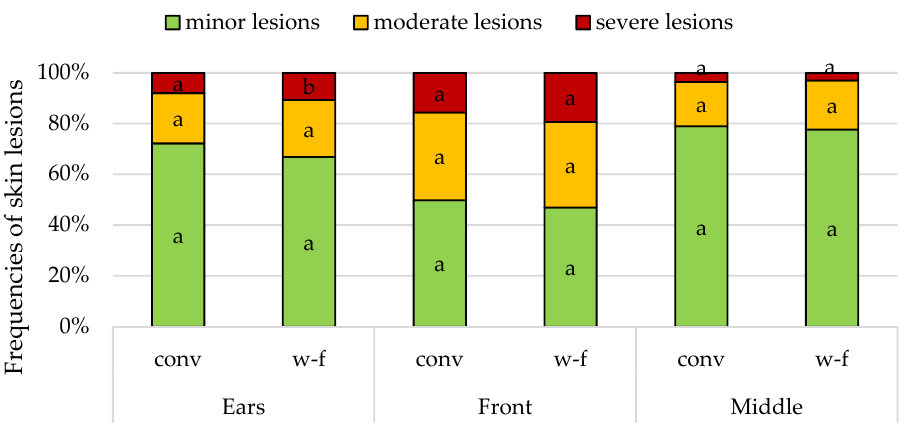
Figure 2. Estimated frequencies (%) of skin lesions per body part and farrowing system on the first day after weaning (FC: farrowing crate; FF: free farrowing pen; GH: group housing of lactating sows; a-c: different letters indicate significant differences within body part and score level ( p < 0.05)). W-f animals showed significantly more severe lesions on the ears than conv piglet, although the difference was small (conv: 7.99% vs. w-f: 10.74%; standard error 0.16 ; p < 0.05; Figure 3).